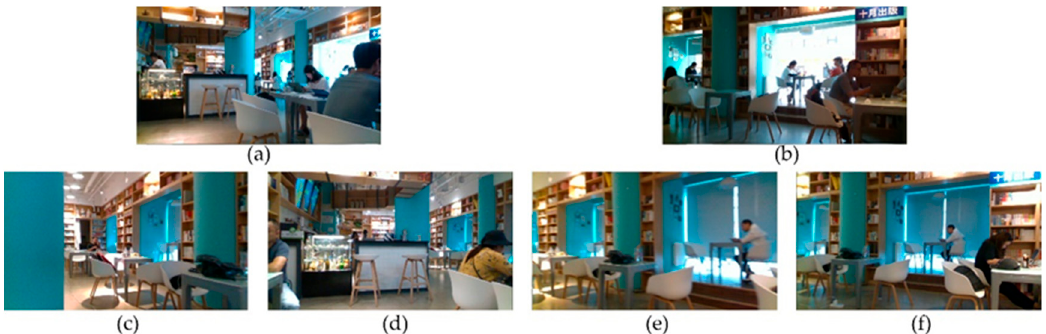
Figure 5. Query images in cafe scene and query results: ( a ) Query image no. 1; ( b ) query image no. 2; ( c ) query result of image 1 with the VLAD method; ( d ) query result of image 1 with our proposed method; ( e ) query result of image 2 with the VLAD method; ( f ) query result of image 2 with our proposed method.